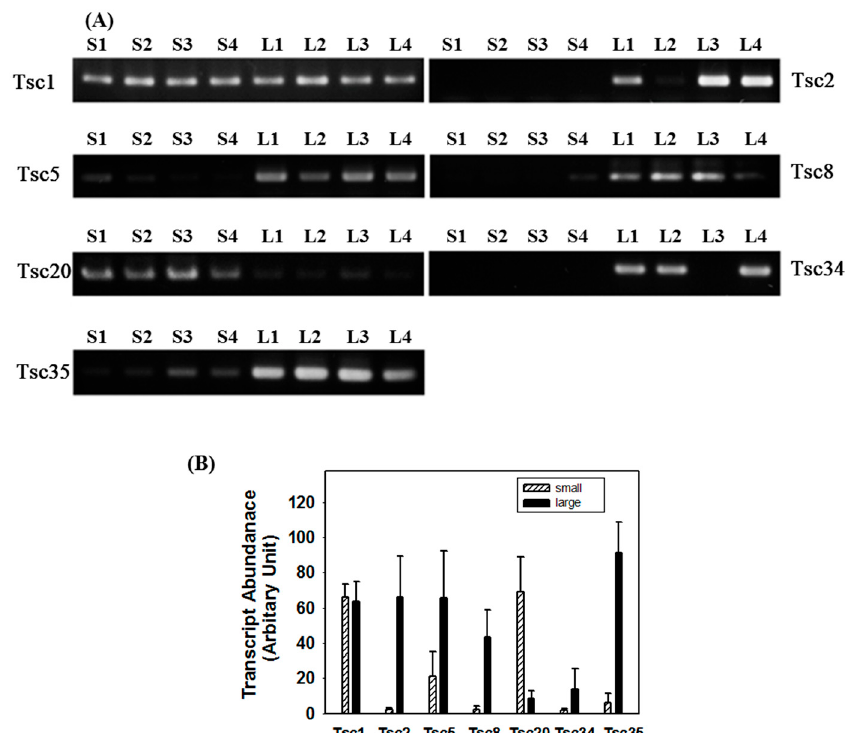
Figure 2. Transcript levels in small and large Pacific abalones. ( A ) RNA was isolated from four abalones in the small (S1–S4) and large (L1–L4) groups and cDNA was synthesized. PCR was carried out using primers specific for ribosomal protein L3 (Tsc1), and differentially-expressed candidates encoding transcripts similar to incilarin A (Tsc2), perlucin (Tsc5), transforming growth factor- β -induced protein ig-h3 (Tsc8), tomoregulin-2 (Tsc20), vitelline envelope zona pellucida domain 4 (Tsc34), and defensin (Tsc35). PCR products were resolved by 2% agarose gel electrophoresis followed by ethidium bromide staining; and ( B ) transcript levels in small (shaded) and large (filled) abalones. Values are expressed as the means with 95% confidence intervals ( n ≥ 8).